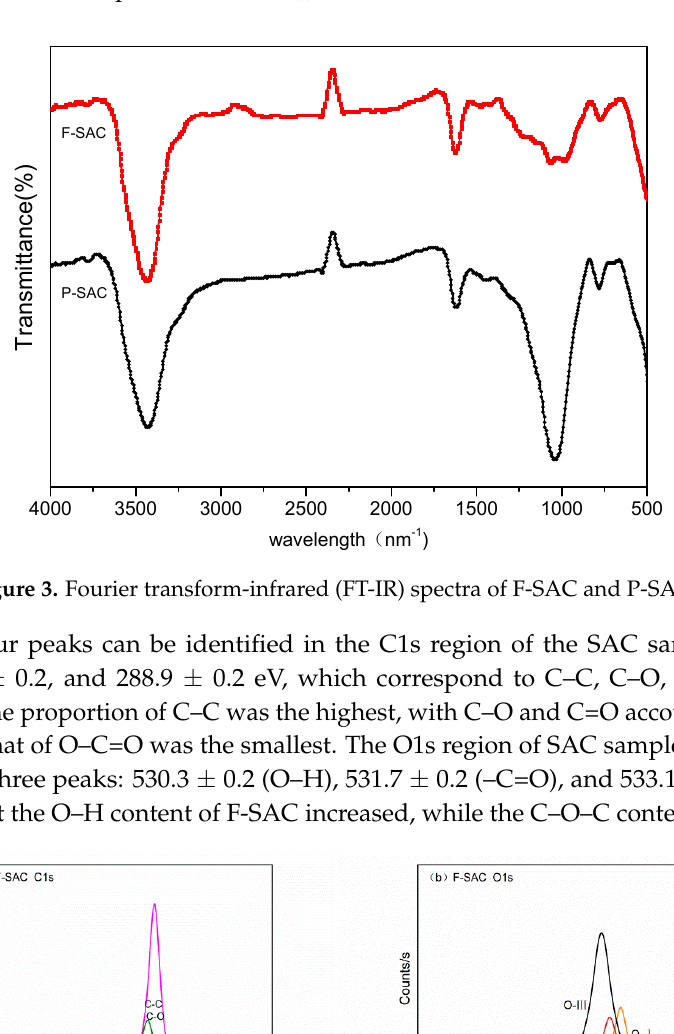
Figure 2. X-ray diffractometry (XRD) of Fenton-activated sludge-derived activated carbon (F-SAC) and untreated SAC (P-SAC).